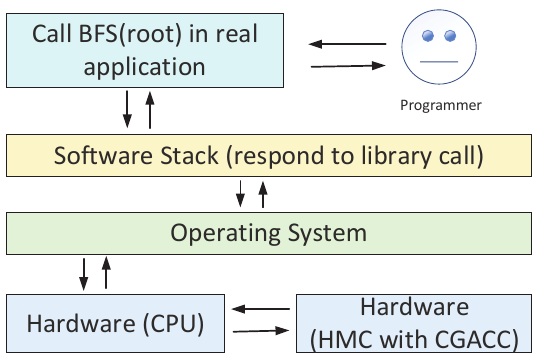
Figure 9. BFSworkflow from programmer to